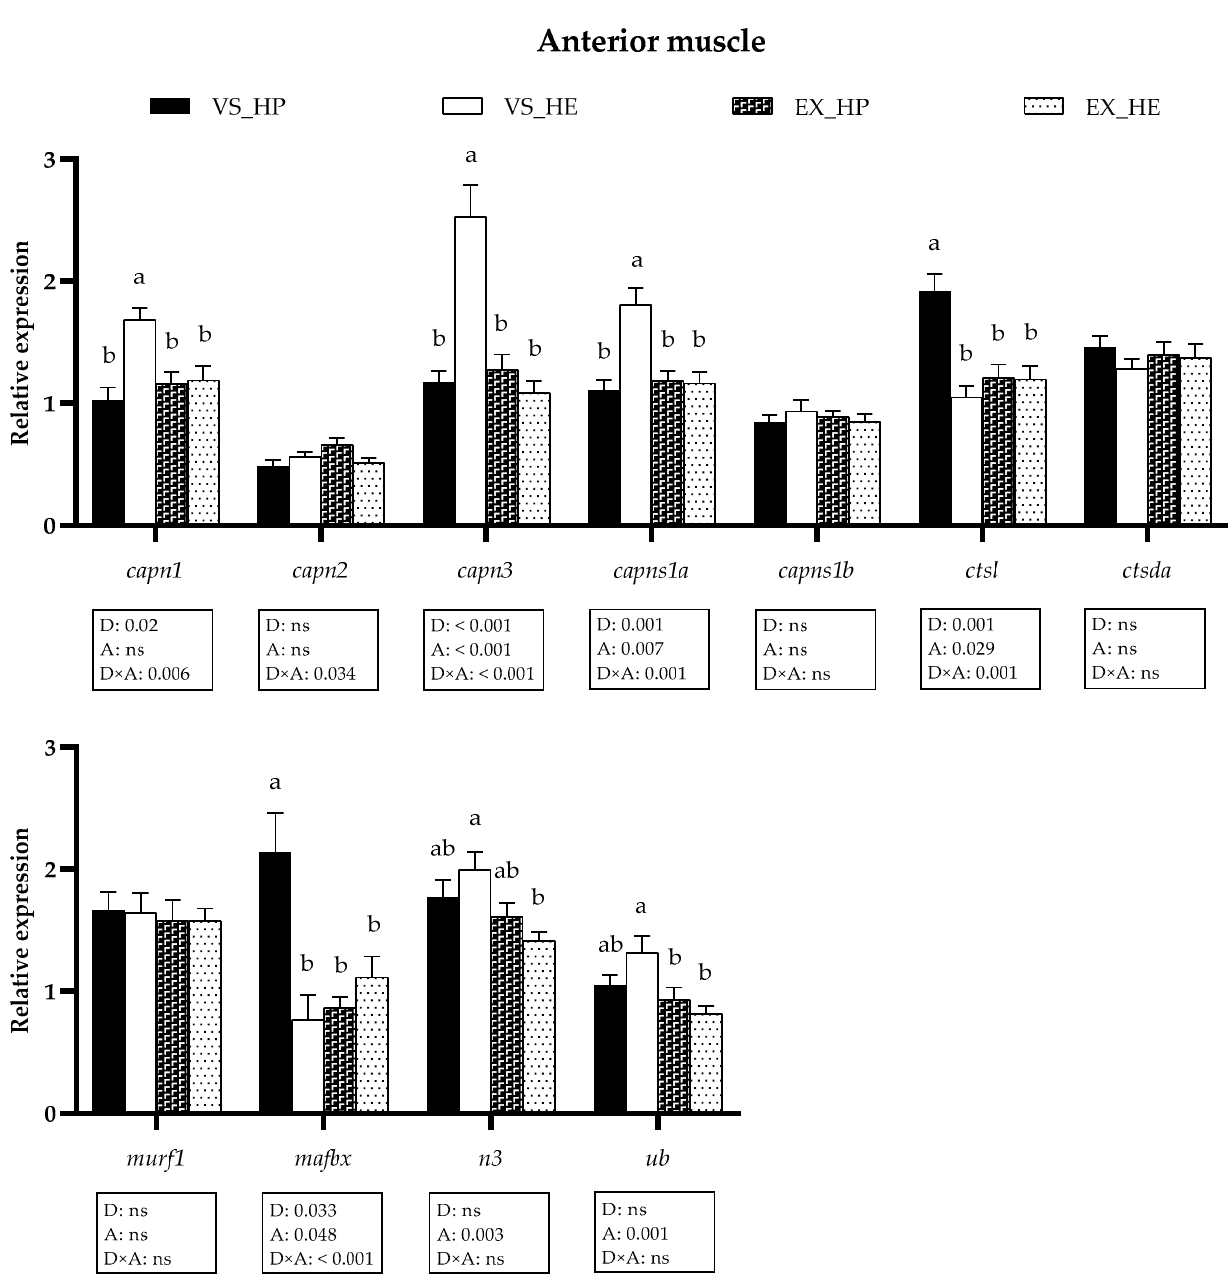
Figure 5. Relative gene expression of proteolytic markers in anterior muscle of fish under voluntary swimming (VS) or sustained exercise (EX) and fed with high-protein diet (HP) or high-energy diet (HE). Data are shown as means + SEM. VS, n = 12; EX, n = 16. Factorial statistical analysis was assessed by two-way ANOVA and p -values of factors diet (D), physical activity (A), and interaction (D × A) are displayed under graph. Different letters indicate significant differences (Tukey’s post-hoc test, p < 0.05).